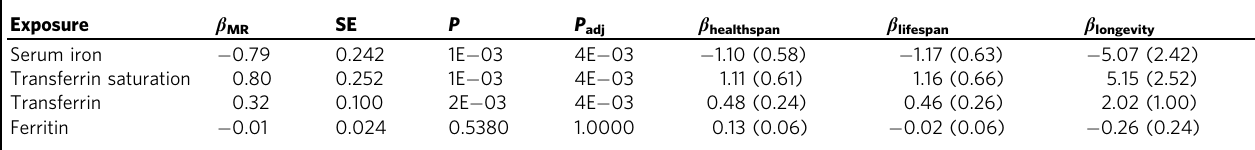
The effects of 15 SNPs genome-wide signi fi cant for one or more iron-related traits were tested against the effects of our GWAS meta-analysis and individual healthspan, parental lifespan, and longevity GWAS in an inverse variance-weighted